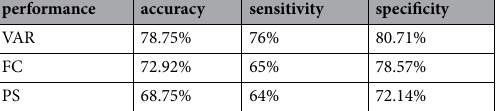
Table 1. Performance of the diagnostic model based on